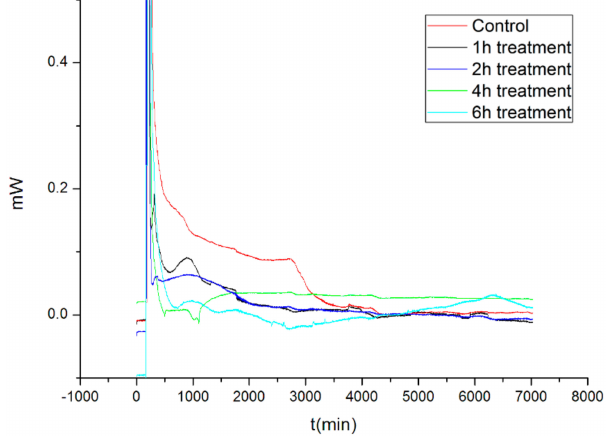
Figure 3. The metabolic heat of M. aeruginosa after nano-TiO 2 mediated photocatalysis.